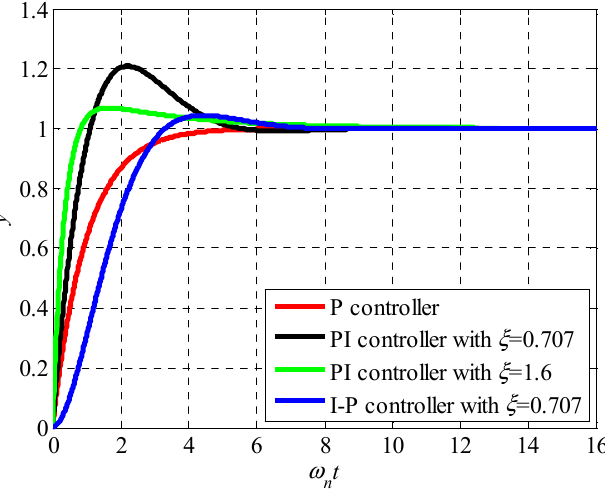
Figure 6. Unit step input response curves of closed-loop systems by using different controllers.